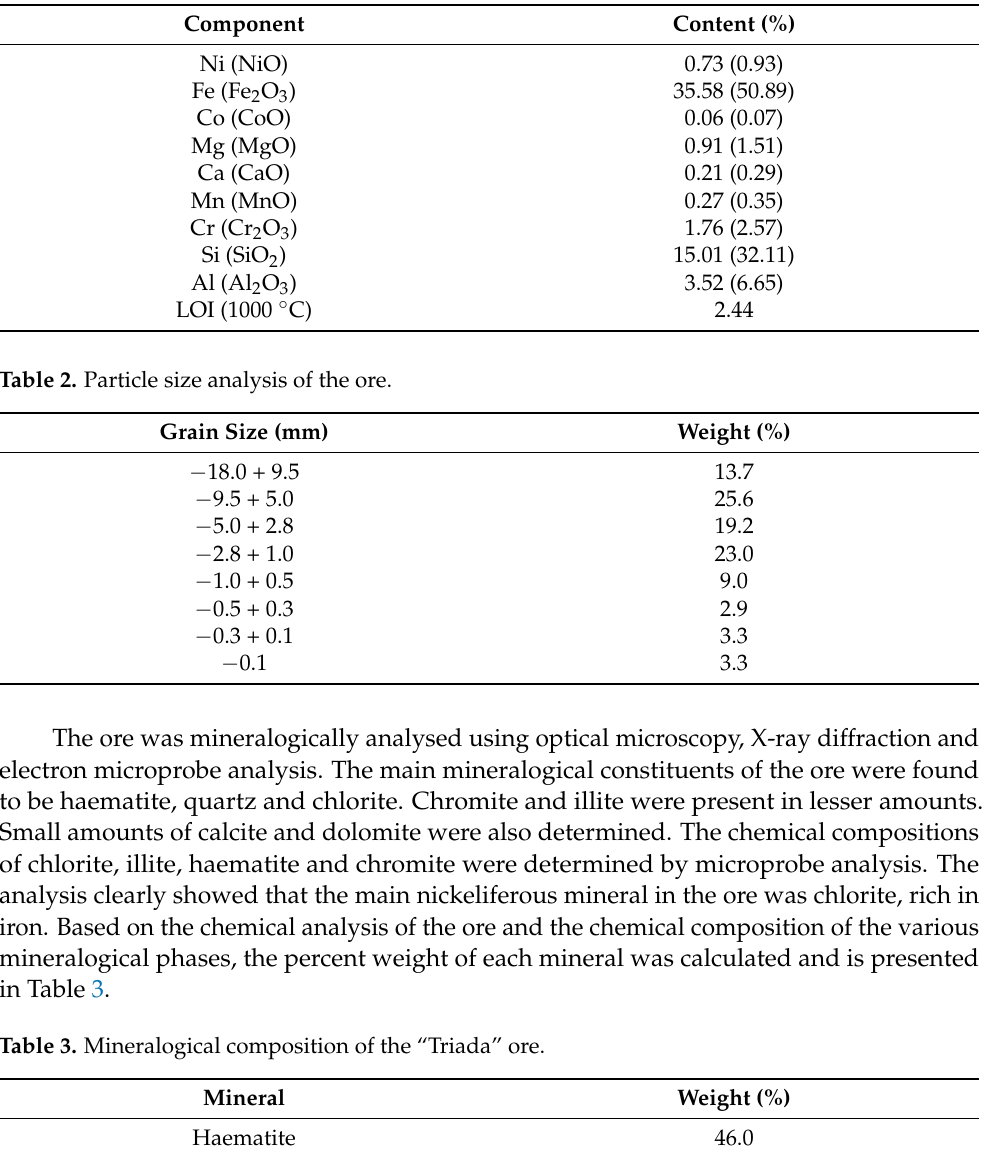
Table 1. Chemical analysis of the ore.